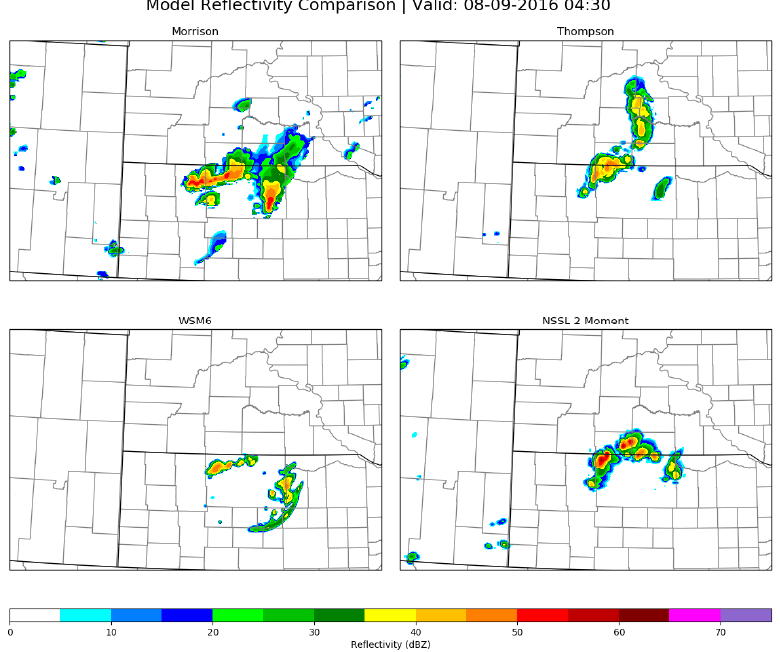
Figure 11. As in Figure 10, but 8.5 h after convective initiation. Images are 16.5-h forecasts valid at 0430 UTC. 0430